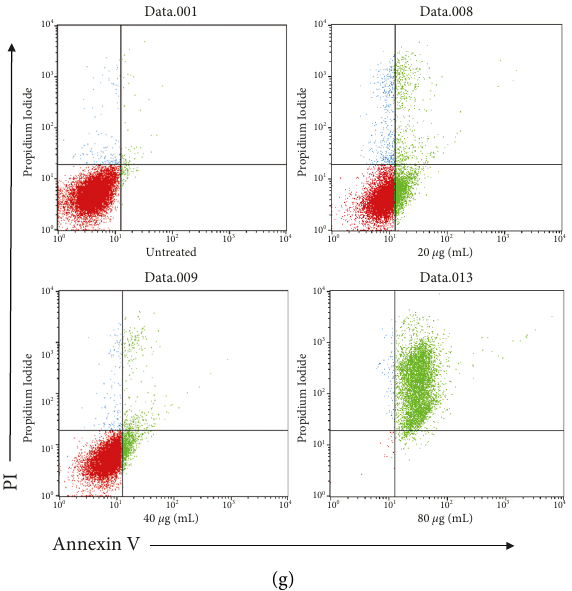
Figure 7: Anticancer activity of B. rotunda extract. (a) Total phenol and flavonoid water and ethanol extracts of B. rotunda . (b) IC for DPPH and NO scavenging tests on aqueous and ethanol extracts of B. rotunda . (c) Toxicity test of aqueous and ethanol extracts of B. rotunda on the cell line T47D. (d) and (f) Rhodamine 123 test results. (e) and (g) Apoptotic test results with annexin V and PI. Different letters in bar indicate significant difference at p 0 . 01. Each value represents the average of three <